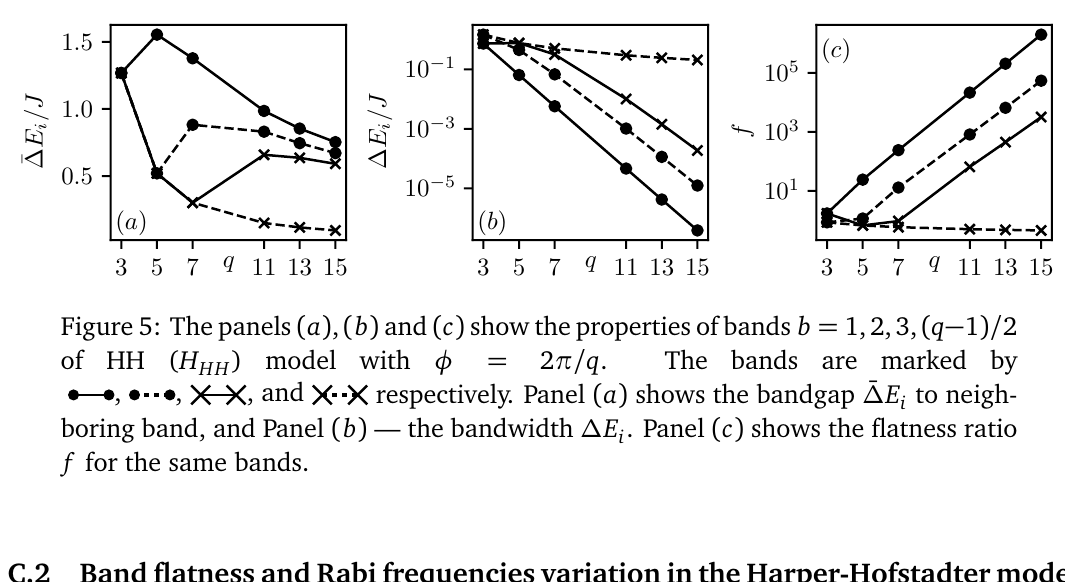
to neigh- i . Panel ( c ) shows the flatness ratio i